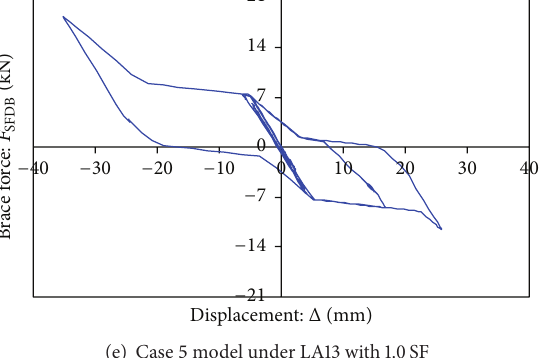
Figure 11: Force and displacement curves for individual SFDB models under the LA28 ground motion with 1.0